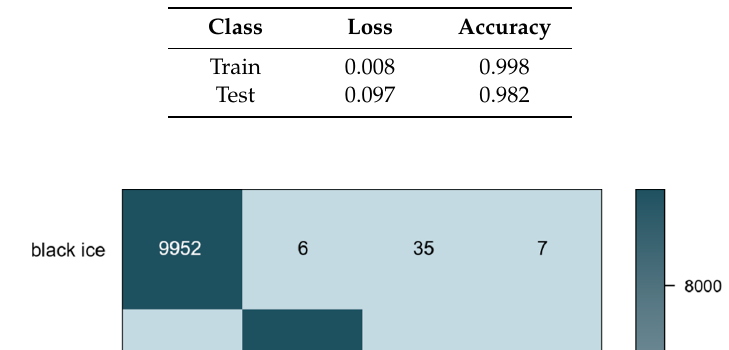
Figure 5. Training result: ( a ) The x -axis of the left graph represents the value of Epoch, the y -axis represents the value of loss; ( b ) the x -axis of the right graph represents Epoch, and the y -axis represents accuracy. Table 9. Training Result.